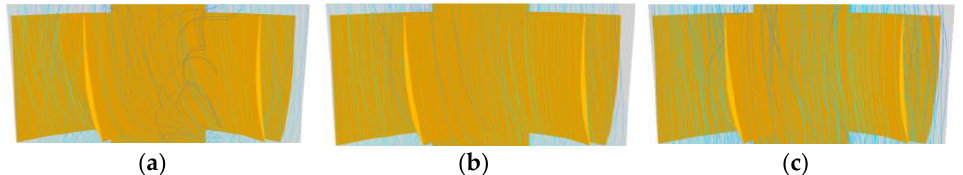
Figure 12. Three-dimensional streamlines diagram of guide vane: ( a ) Q = 0.8 Q bep ; ( b ) Q = 1.0 Q bep ; ( c ) Q = 1.2 Q bep .